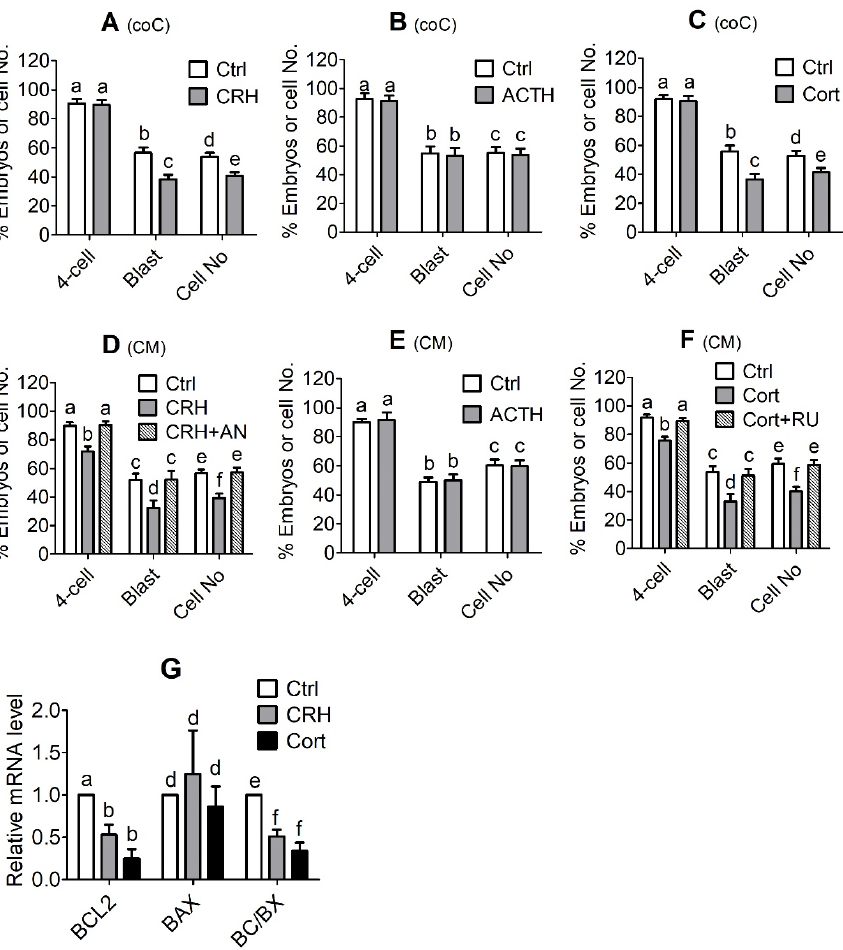
Figure 3. In vitro development and apoptosis of pig embryos cocultured with oviduct epithelial